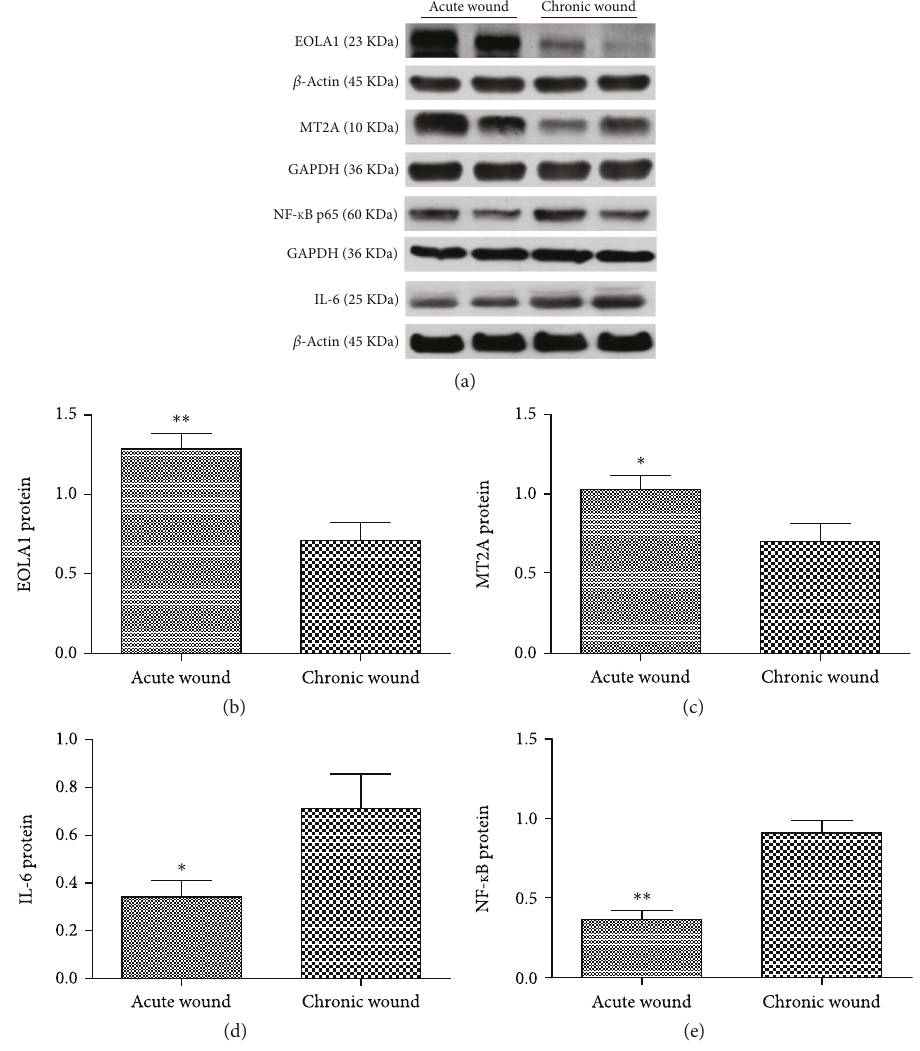
Figure 4: Expression of EOLA1, NF- κ B, IL-6, and MT2A in the diabetic wound tissues by western blot (a) and ratios of EOLA1/ β -actin (b), NF- κ B P65/GAPDH (c), IL-6/GAPDH (d), and MT2A/ β -actin (e) in the wounds from the two groups. ∗ P < 0 05 , ∗∗ P < 0 01